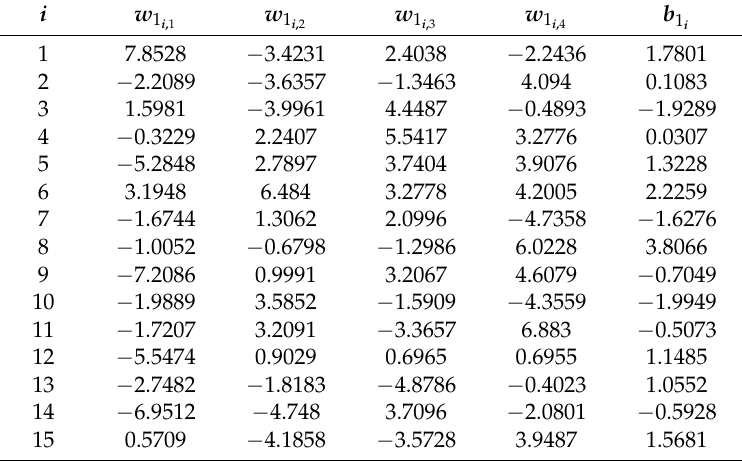
Table 4. Weight and biases of each neuron in the first hidden layer in the ANN structure of the gas solubility